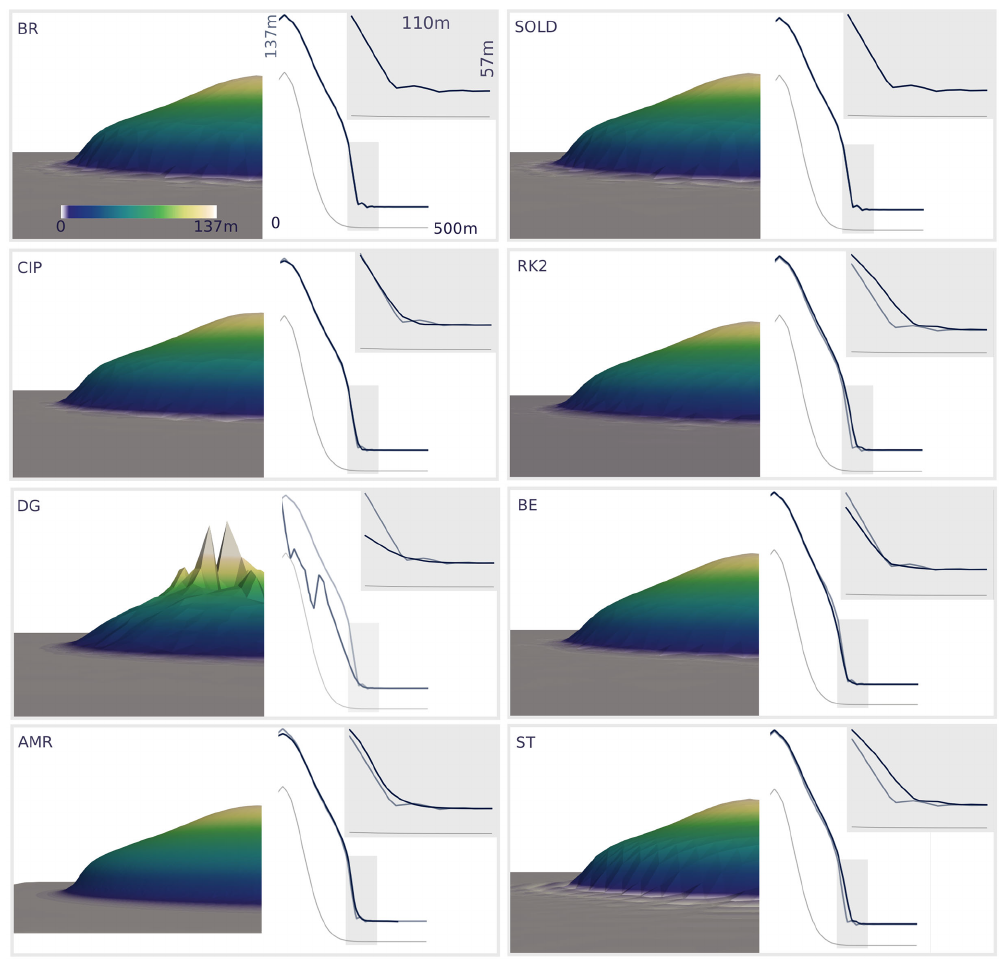
Figure 13. The left panels show results of the hill test for stabilised simulations after 23 years using BR (bubble-enriched), CIP (continuous interior penalty), DG (discontinuous Galerkin), AMR (adaptive mesh refinement), SOLD (oscillations at sharp layer diminishing), RK2 (Runge–Kutta time discretisation), BE (backward Euler time discretisation) and ST (structured mesh). The right panels show a cross-profile along the y axis of surface (blue) and bed (grey) elevation; insets show a zoom of the opaque grey regions; the bold grey line indicates the reference solution using the SUPG and Crank–Nicholson setup (see also Fig.